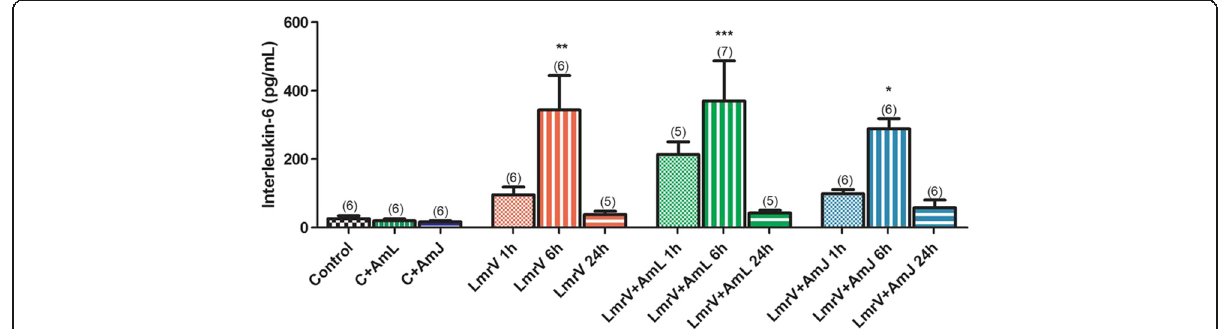
Fig. 5 Interleukin-6 concentration of male Wistar rats injected with 3 mg of Lachesis muta rhombeata venom, at 1, 6 and 24 h after envenomation (LmrV) and with their respective treatment with aqueous extract of Annona muricata L. leaves (LmrV + AmL) or Annona muricata L. juice (LmrV + AmJ). The numbers above the columns represent the number of animals used in each test. *** p < 0.001, ** p < 0.01, * p < 0.05 compared to control